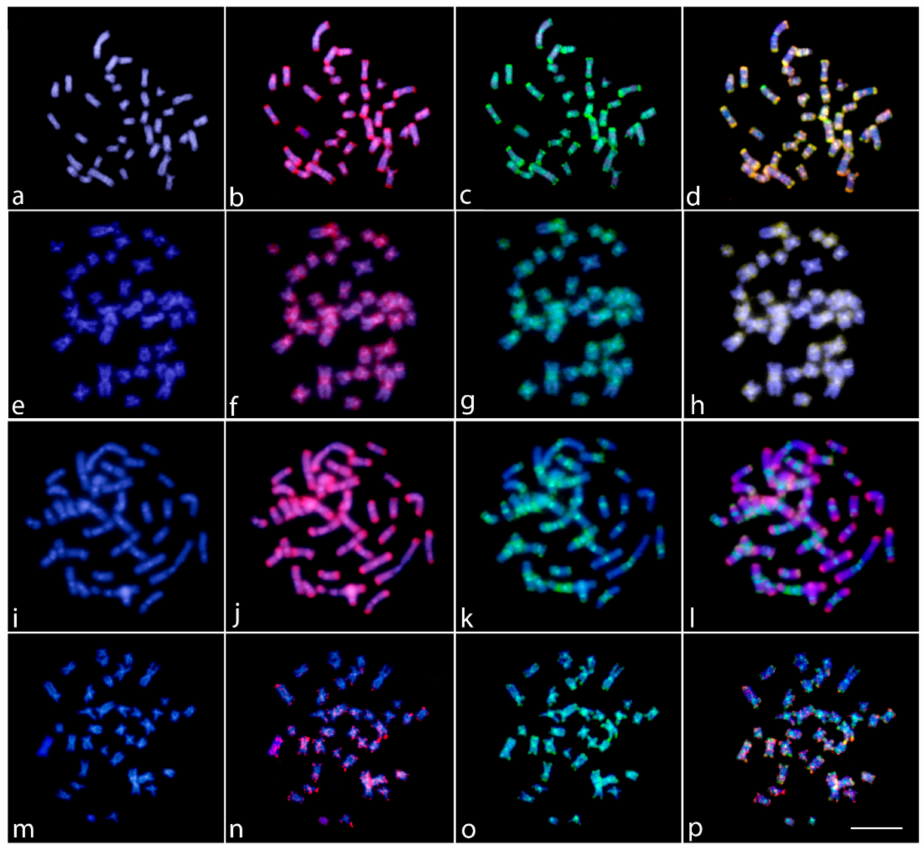
Figure 5. Comparative genomic hybridization (CGH) for intra- and interspecific comparison in the female metaphase plates of Lebiasina bimaculata ( a – d and m – p ) and L. melanoguttata ( e – h and i – l ). Male- and female-derived genomic probes from L. bimaculata mapped against female chromosomes of L. bimaculata ( a – d ); Male- and female-derived genomic probes from L. melanoguttata mapped against female chromosomes of L. melanoguttata ( e – h ); female-derived genomic probes from both L. bimaculata and L. melanoguttata hybridized together against female chromosomes of L. melanoguttata ( i – l ); and female-derived genomic probes from both L. bimaculata and Boulengerella lateristriga (Ctenolucidae) hybridized together against female chromosomes of L. bimaculata ( m – p ). First column ( a , e , i , m ): DAPI images (blue); second column ( b , f , j , n ): hybridization patterns using male gDNA of L. bimaculata ( b ), male gDNA of L. melanoguttata ( f ), female gDNA of L. melanoguttata ( j ), and female gDNA of B. lateristriga probes (red); third column ( c , g , k , o ): hybridization patterns using female gDNA of L. bimaculata ( c , o ) and female gDNA of L. melanoguttata ( g , k ) probes (green); fourth column ( d , h , l , p ): merged images of both genomic probes and DAPI staining. The common genomic regions are depicted in yellow. Scale bar = 5 µ